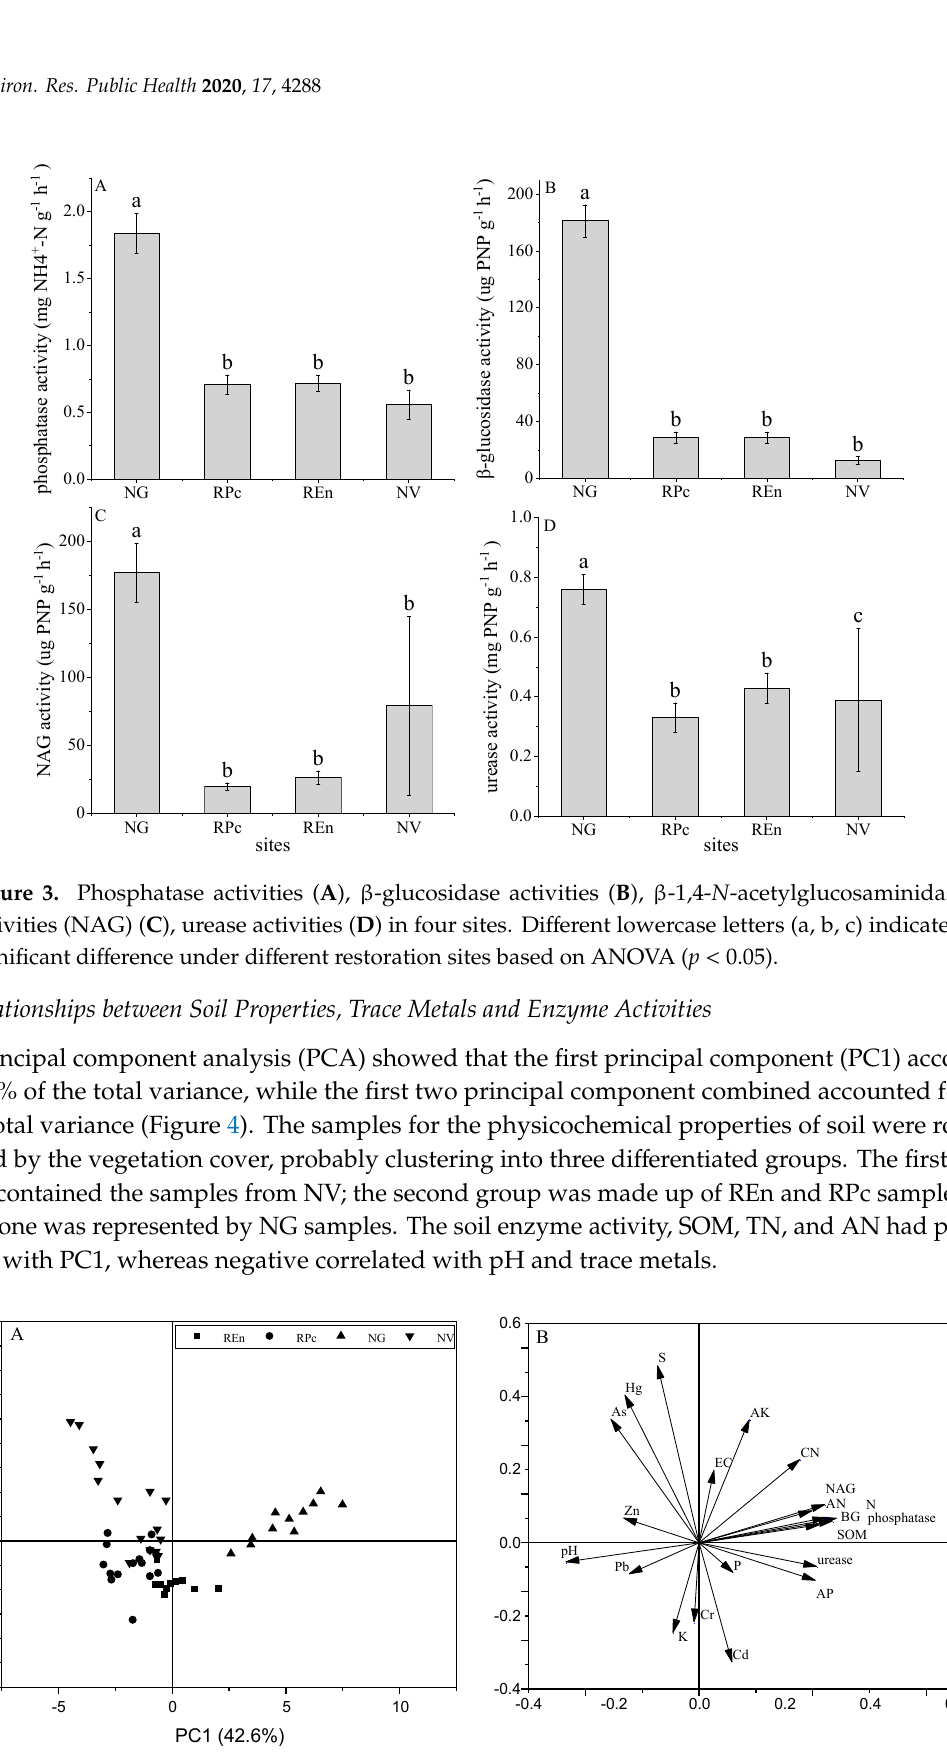
Figure 4. Biplot of the first and second axes obtained from the principal component analysis showing dependencies between soil quality indicators. Principal component analysis scores ( A ) and loadings ( B ).